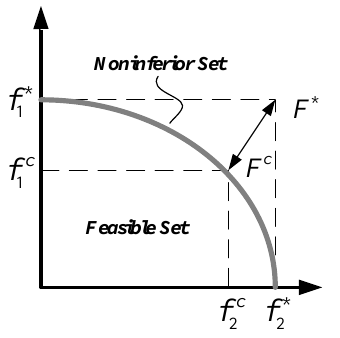
* represents the de- f represents the de- 1 1